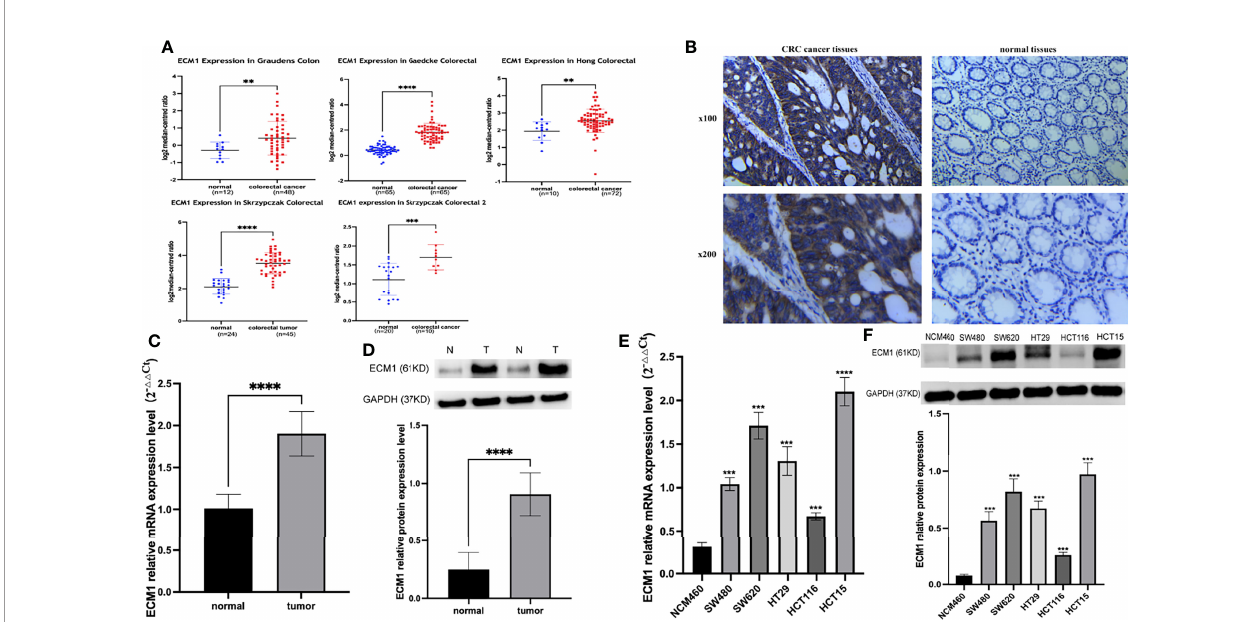
FIGURE 1 | Analysis of ECM1 expression in CRC tumors and cell lines. (A) ECM1 levels in CRC patient tumors and adjacent normal tissue samples were analyzed using the Oncomine database. (B) Representative IHC staining results for CRC patient tumor and paracancerous tissues. (C) ECM1 mRNA expression in CRC tumors and paracancerous tissues. (D) ECM1 protein levels in CRC tumors and paracancerous tissues. (E) ECM1 mRNA levels in CRC and colonic epithelial cell lines. (F) ECM1 protein levels in CRC (SW480, SW620, HT29, HCT116, HCT15) and colonic epithelial (NCM460) cell lines. Data are means ± SD (**P < 0.01, ***P < 0.001, ****P <